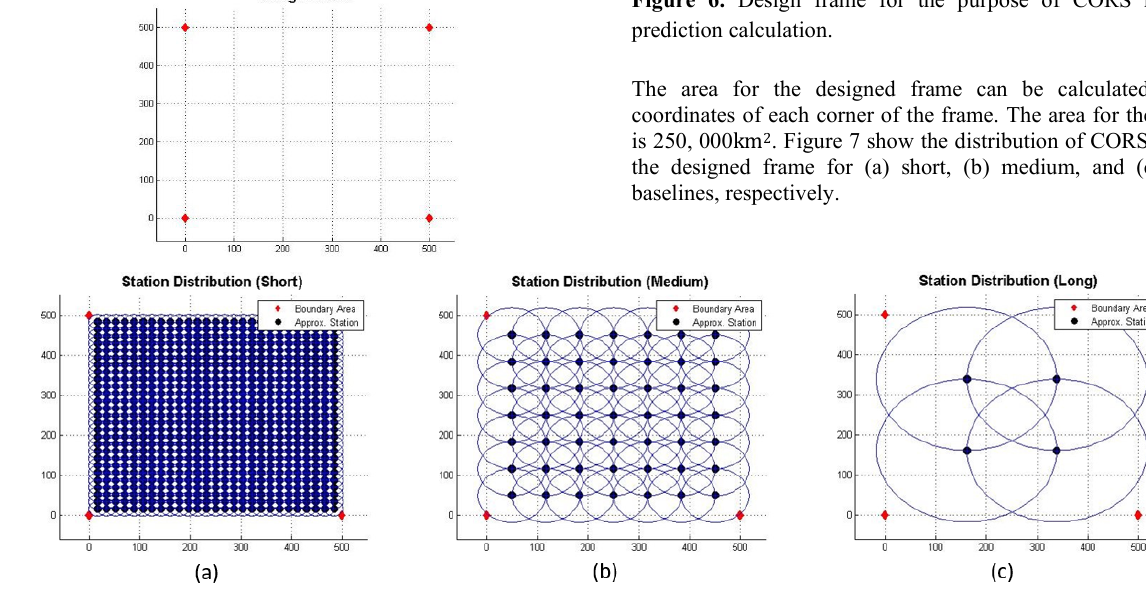
Figure 6. Design frame for the purpose of CORS number prediction calculation.